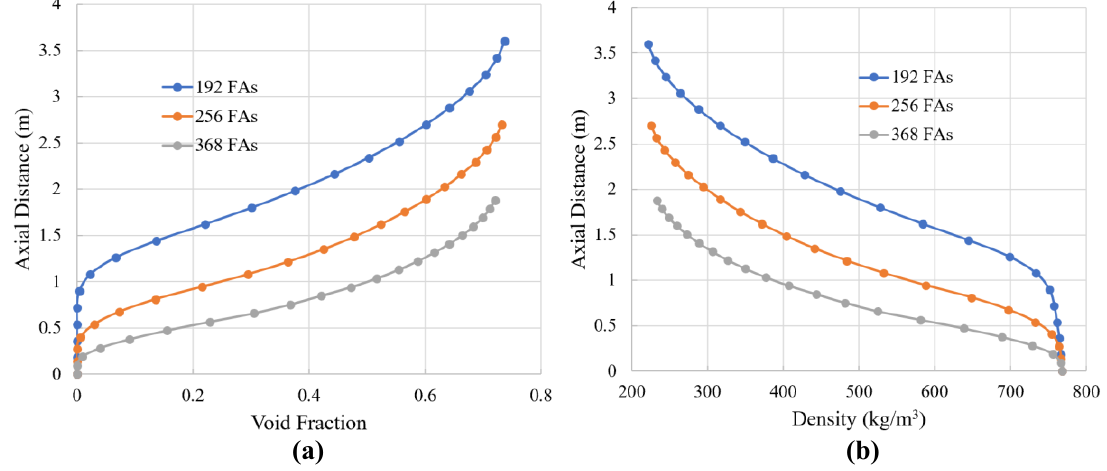
Figure 9. Core Axial Profile at MOL: (a) Void Fraction; (b)